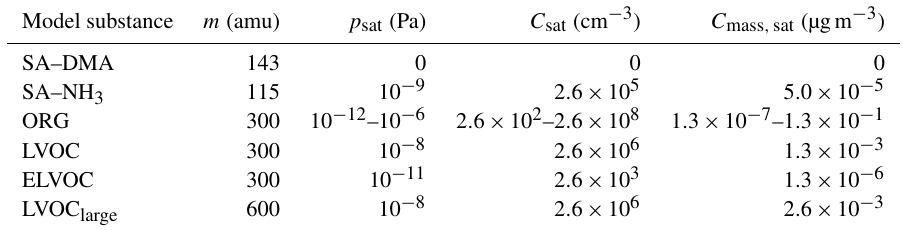
Table 2. Model compounds, their molecular mass ( m ), saturation vapor pressure ( p sat ) and the corresponding number concentration ( C sat ) and mass concentration ( C mass , sat ) at T = 278K. Note that LVOC and ELVOC are two cases of the organic compound (ORG) selected for more detailed studies.